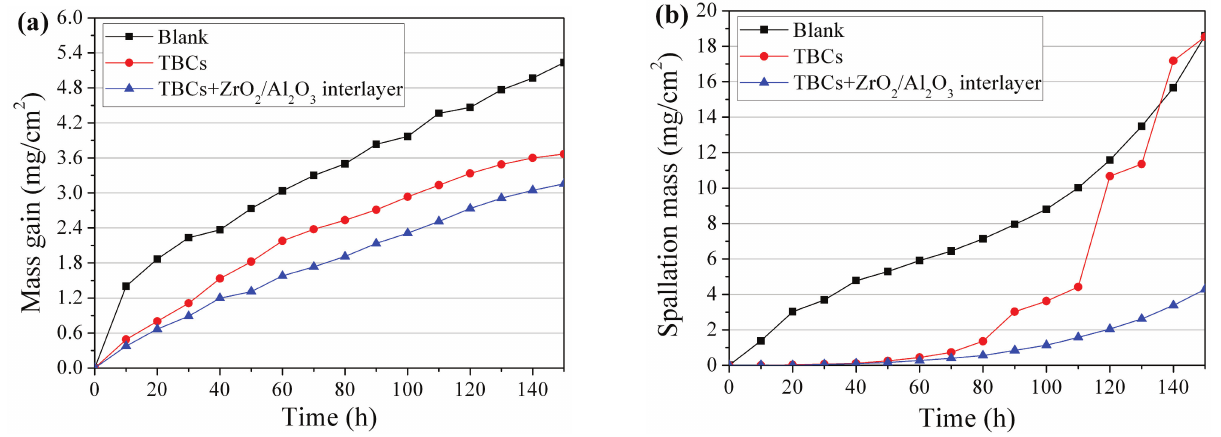
Figure 5. Oxidation kinetic curves of specimens with various coatings after oxidation at 1000 ı C for 15 h: (a) mass gain versus time and (b) scale spallation versus time.